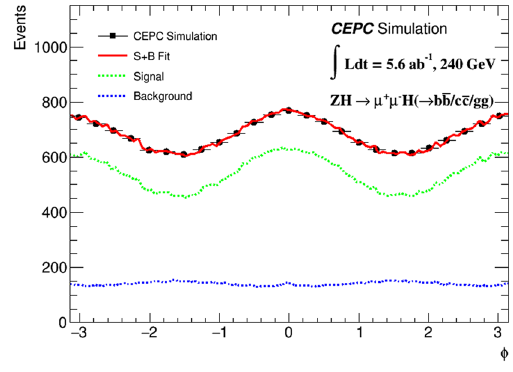
Fig. 5 Fit result projected on φ distribution in μ + μ − H channel